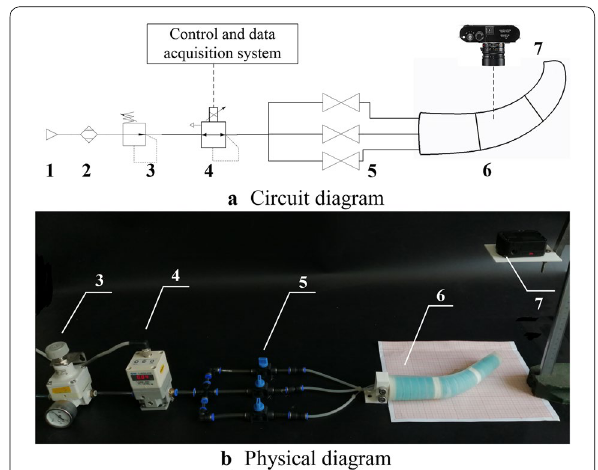
Figure 9 Schematic of bending angle testing system. 1. Air source; 2. Dryer; 3. Reducing valve; 4. Proportional pressure valve; 5. Shut-off valve; 6. Finger; 7. HDTV camera